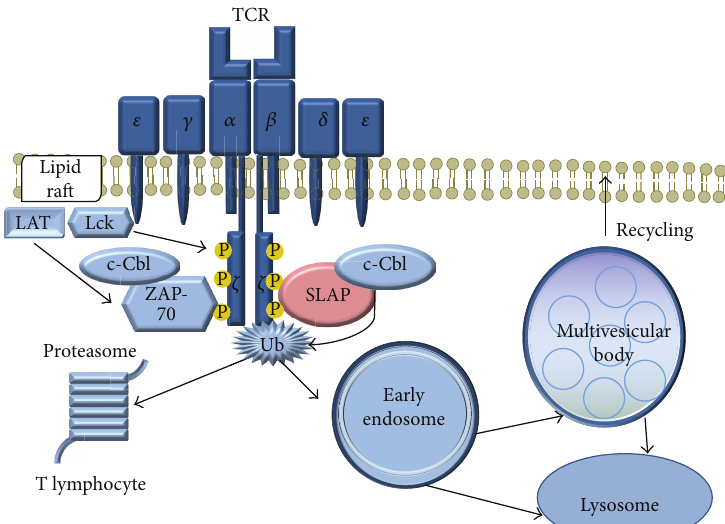
Figure 3: The role of SLAP in T lymphocytes.